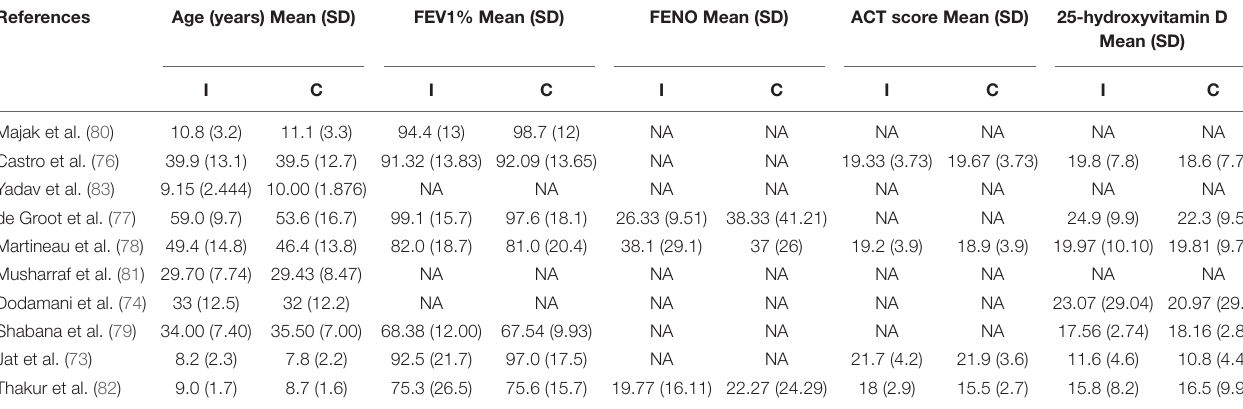
TABLE 2 | Baseline characteristics of patients in the eight studies